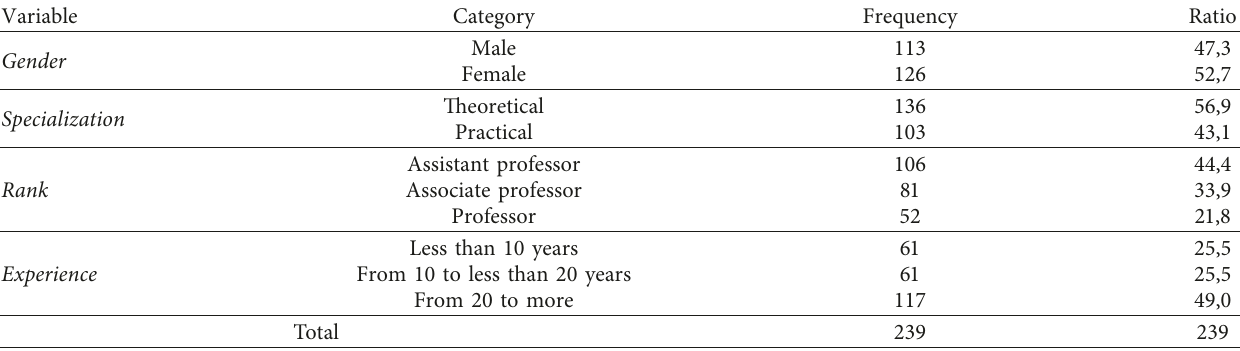
Table 1: Distribution of the study sample according to its main